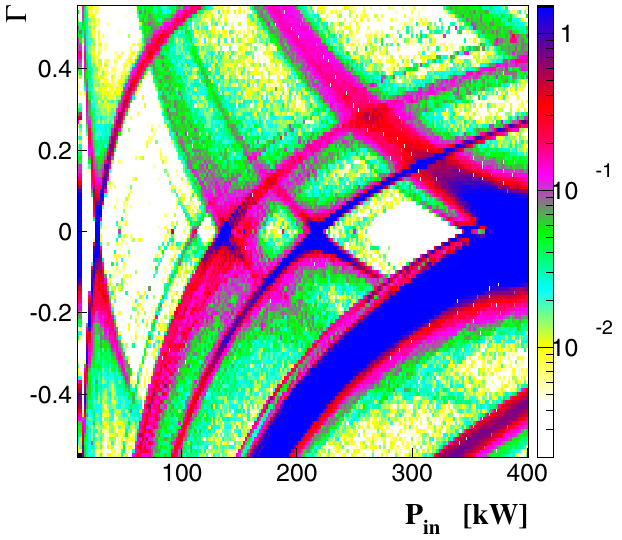
FIG. 3. (Color) Multipactoring zone map for the coaxial line of the ARES input coupler, showing the quantity M defined in Eq. (5). The horizontal axis indicates the time average of the input rf power, and the vertical one for the reflection